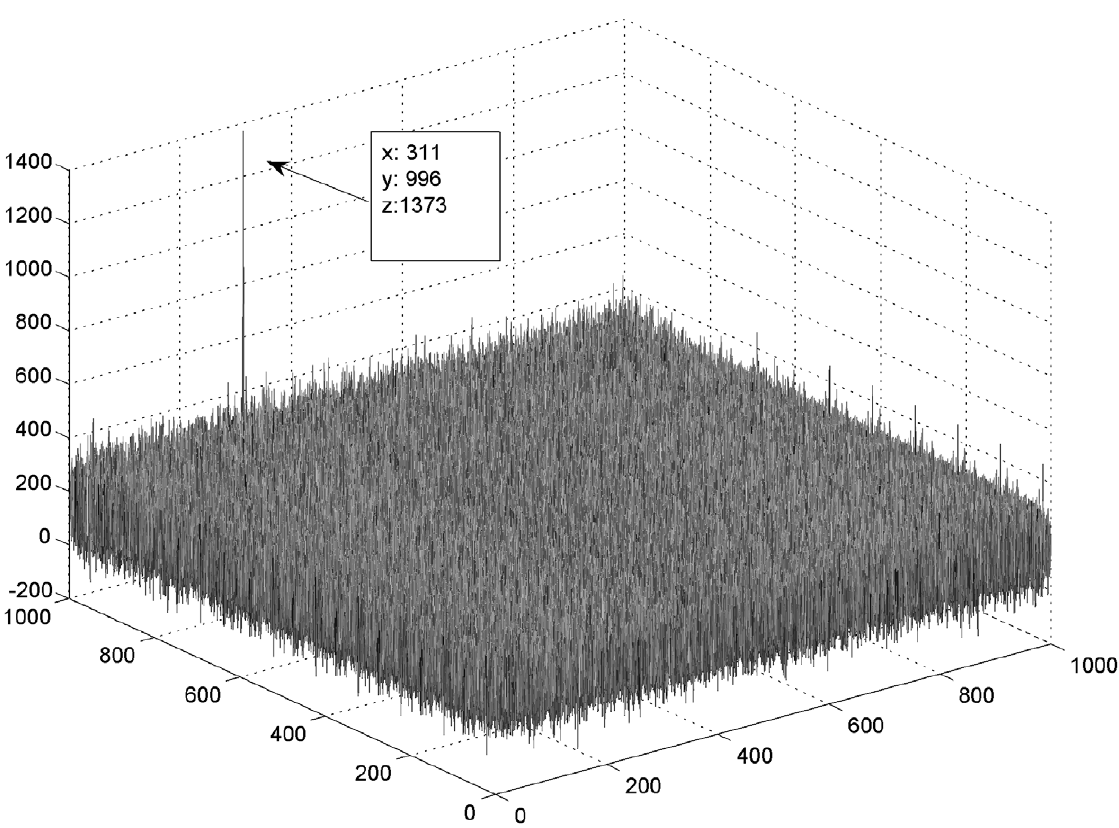
Figure 9. Correlation with great data bases. The figure presents the correlation result of the sequence so33 (400 bases) correlated with a scene that contains the complete database (1000 6 1000 bases). This shows that the size of the scenes may also vary.